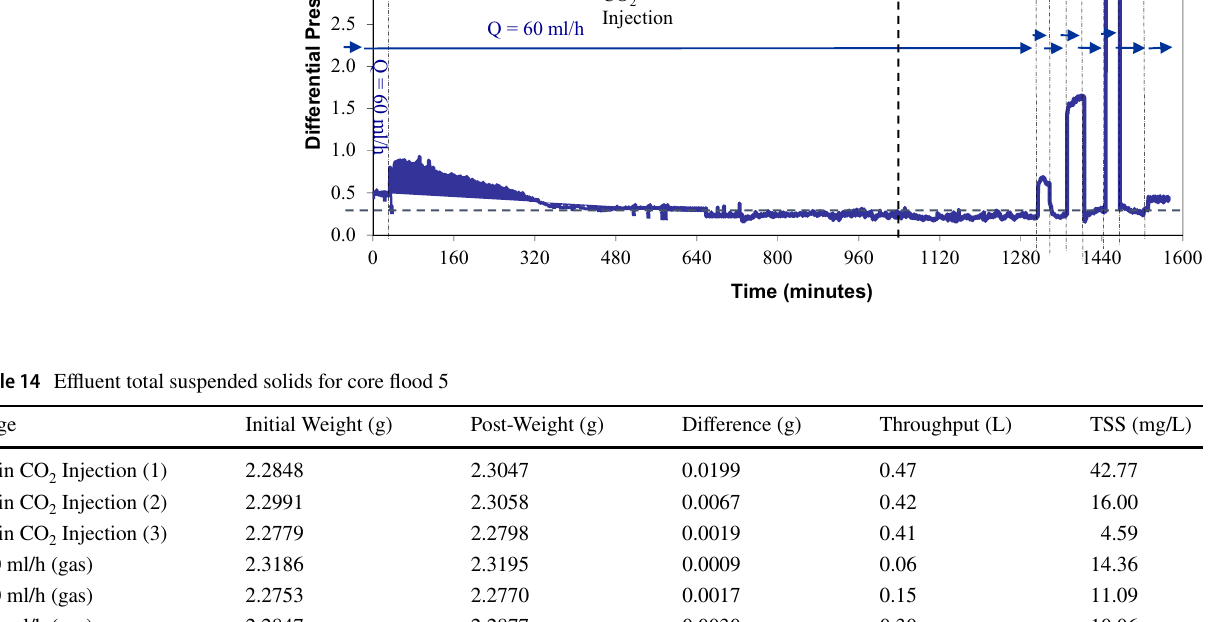
Fig. 10 Differential pressure versus time profile recorded during CO 2 -saturated brine saturations at incremental rates and intermediate baseline satu- rations for core flood 5. Condi- tions: Po = 3172 psi, Pp = 1450